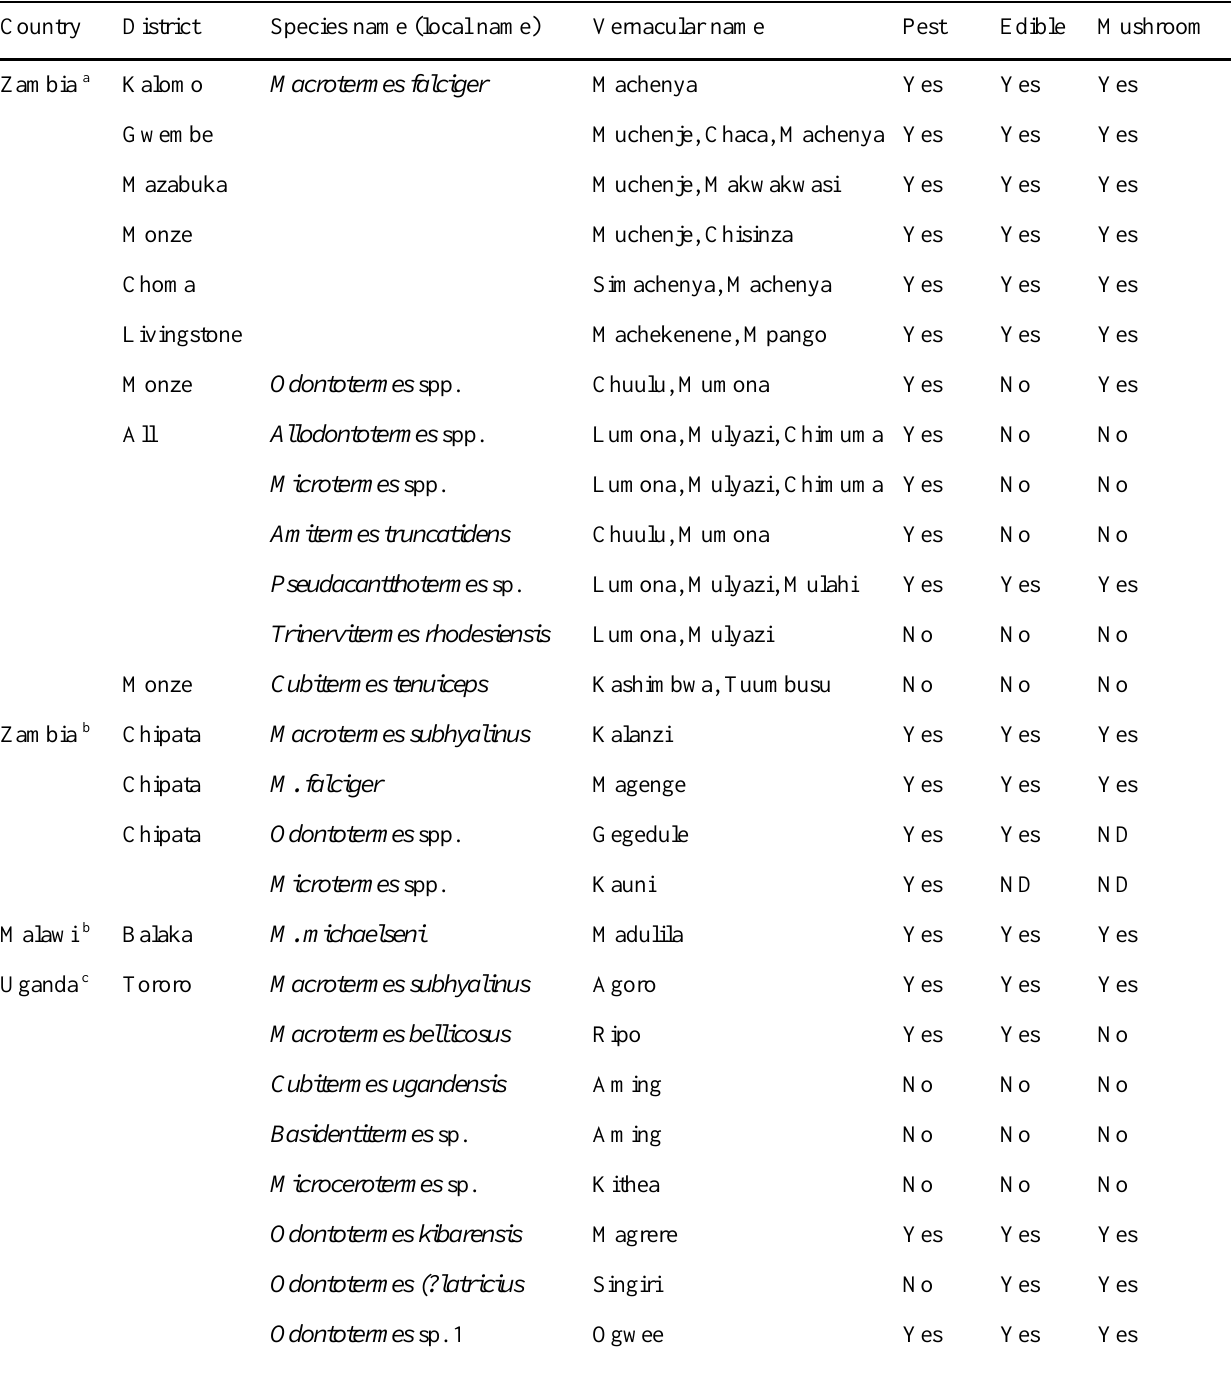
Table 1. List of termite genera and species, their corresponding vernacular names, indigenous knowledge of their pest status, and uses as sources of food and mushrooms in Zambia, Malawi, Uganda, and Kenya